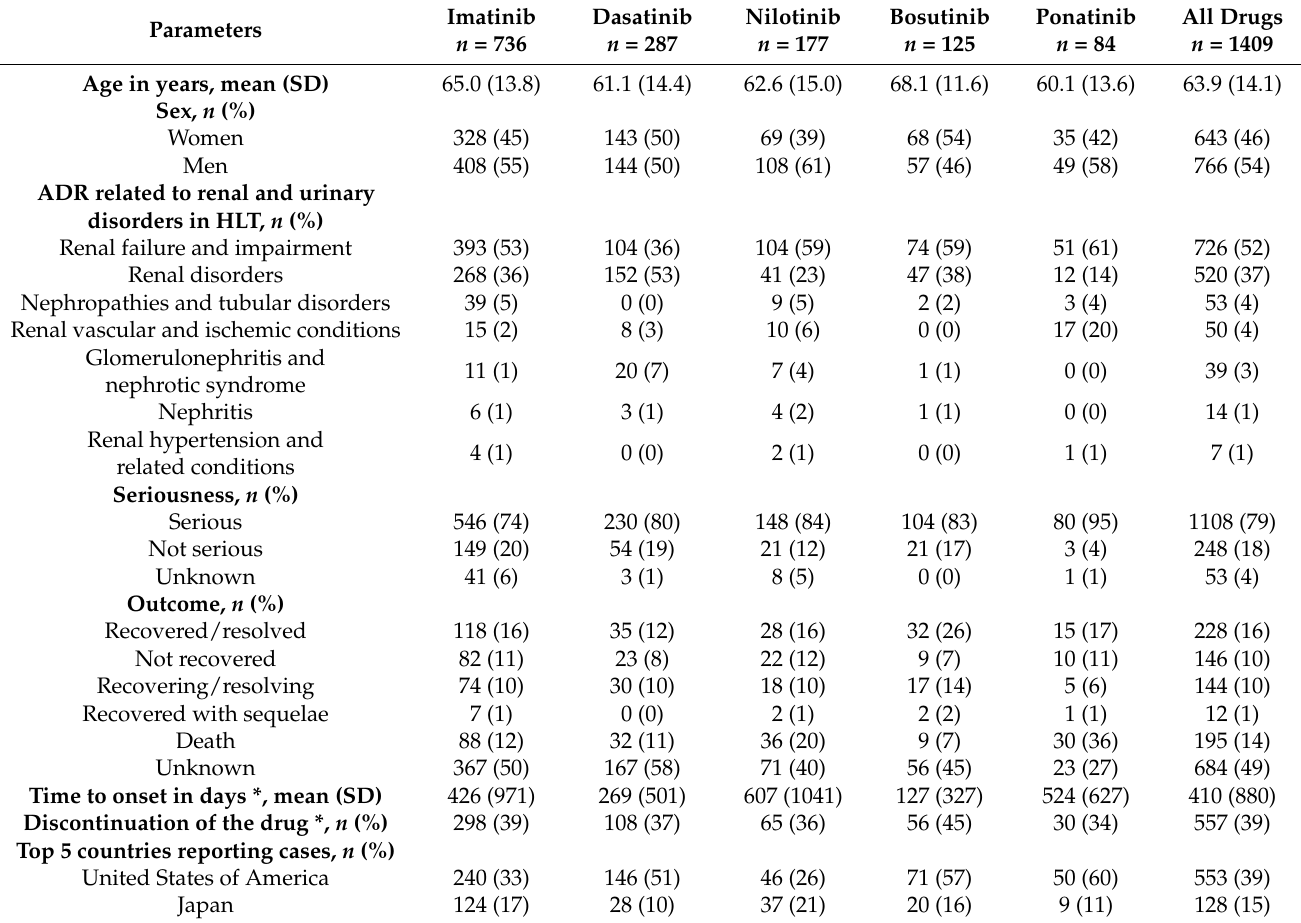
Table 1. Main characteristics of the 1409 cases of nephrotoxicity related to BCR-ABL